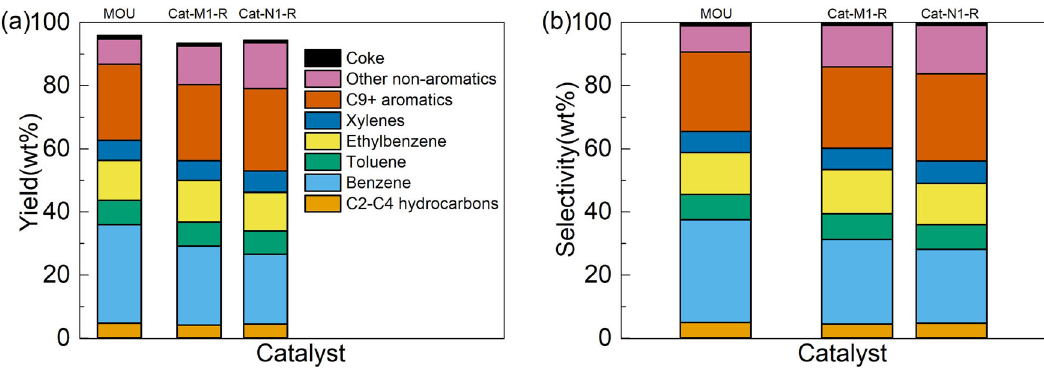
Fig. 4 Product distribution of n -butylbenzene reactions over regenerated catalysts. a Yield, b selectivity. The unconverted n -butylbenzene has been excluded from the product, and the results over fresh catalyst are also presented for easier